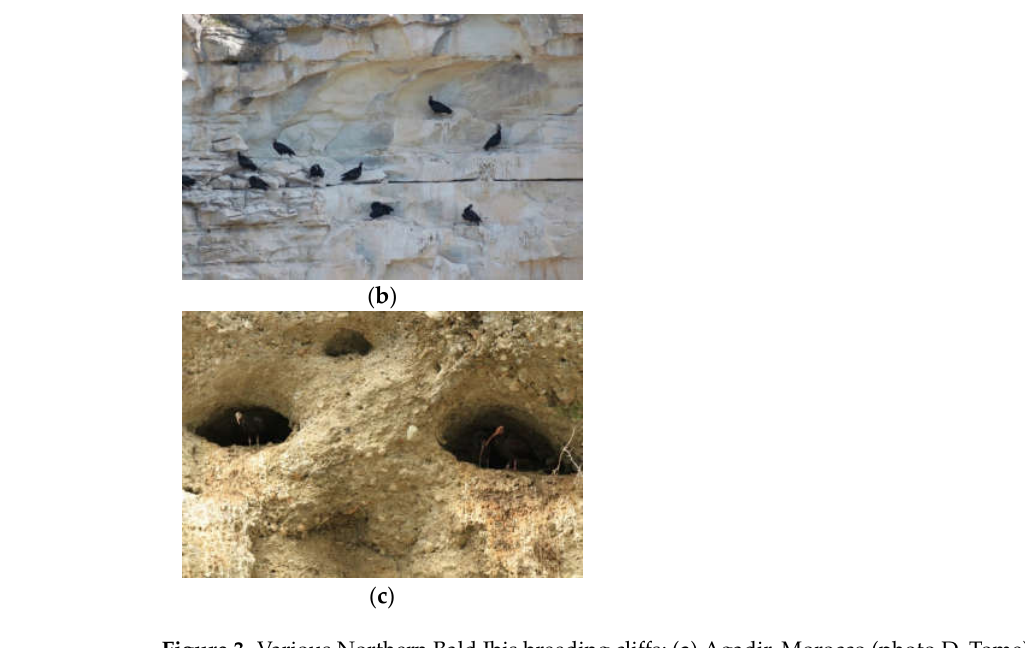
Figure 3. Various Northern Bald Ibis breeding cliffs; ( a ) Agadir, Morocco (photo D. Tome); ( b ) Birecik, Turkey (photo J. Fritz); ( c ) Kuchl, Austria (photo J. Fritz).